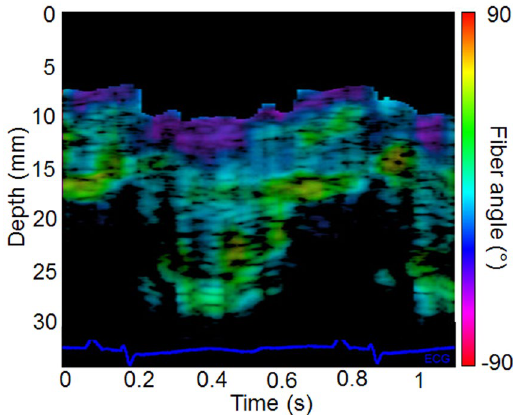
Figure 5. Fiber orientation temporal variation. In vivo fiber angle variation in the left ventricular wall within a cardiac cycle as a function of depth and time. The color scale represents the value of the fiber angle superimposed onto a standard M-mode of the left ventricle. The associated ECG is displayed at the bottom of the figure.